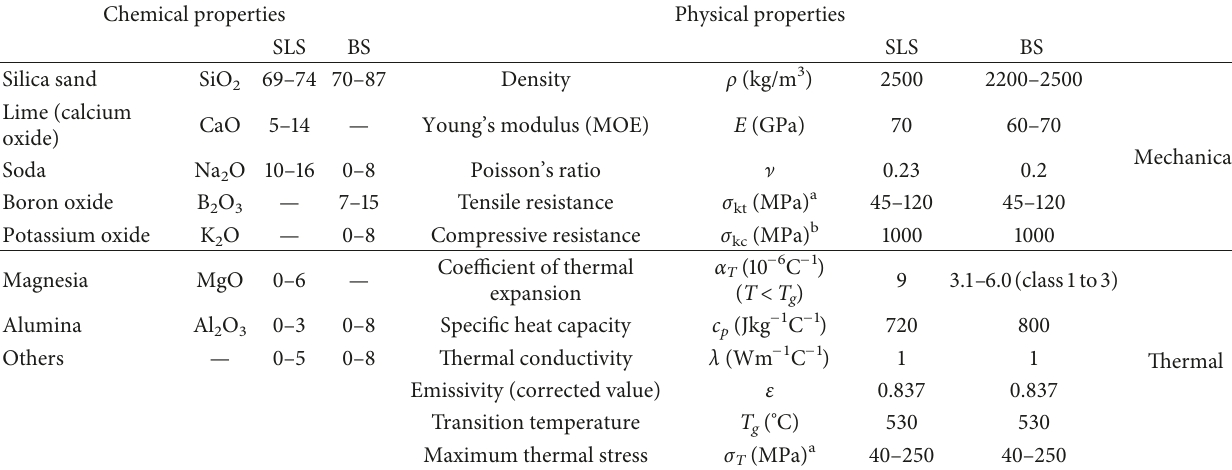
Table 1: Chemical and physical properties of SLS and BS glass types (at room temperature), in accordance with [1]. Chemical